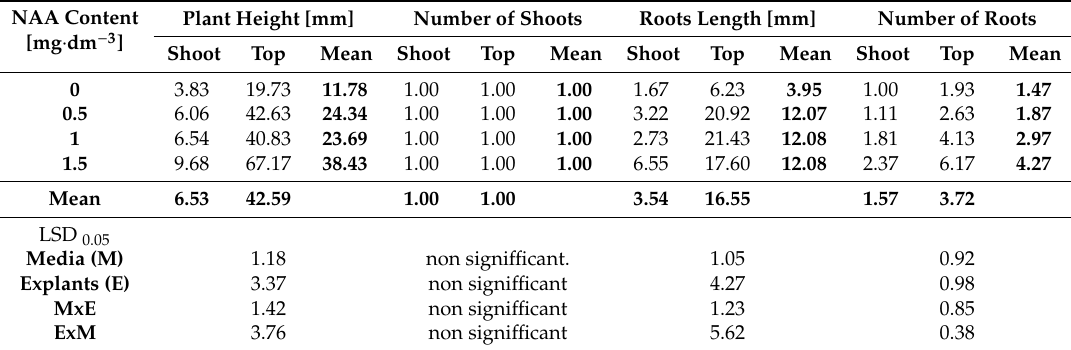
Figure 6. Top ( a ) and shoot ( b ) explant propagated on the MS medium supplemented with 1 mg ∙ dm − 3 of kinetin (KIN) after 6 weeks of growth. Table 2. E ff ects of type explants and 1-naphthaleneacetic acid (NAA) content on the rooting of Honckenya